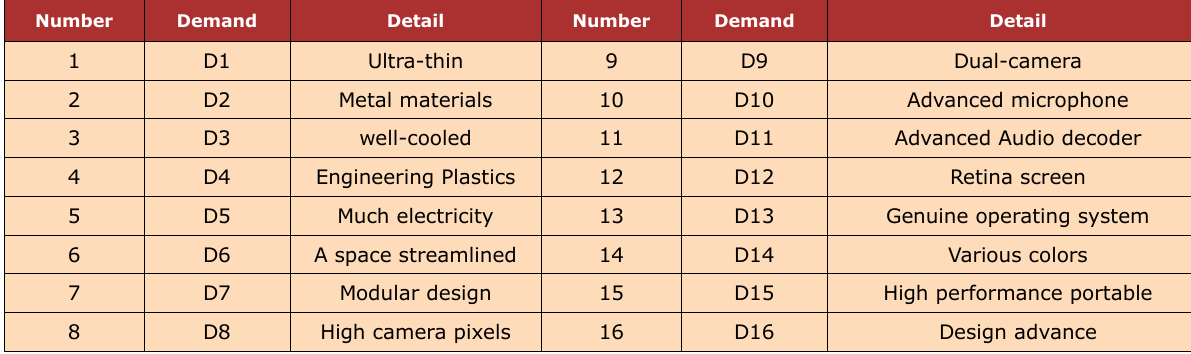
Table 1. Customers demand